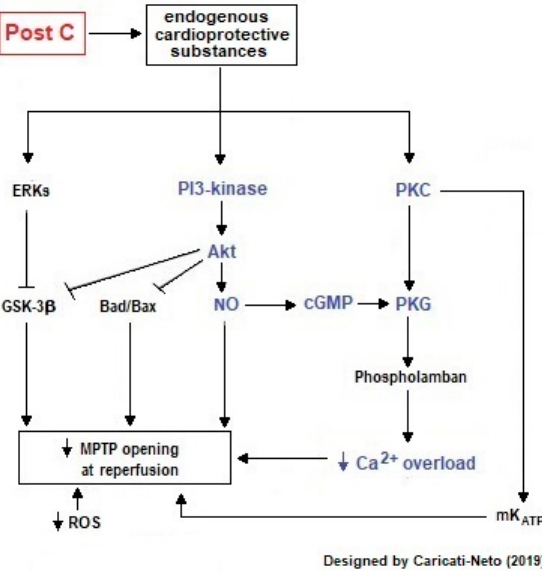
Figure 4. Intracellular signaling involved in cardioprotective response stimulated by ischemic postconditioning (PostC) in cardiac cells. This figure illustrates that PostC activates cellular survival pathways mediated by PI3K / Akt and increases cytosolic levels of NO in cardiac cells. This increase in NO biosynthesis activates intracellular signaling mediated by GC / cGMP / PKG pathway that produces increments in the activity of mK ATP channels, preserving the mitochondrial bioenergetics, and preventing the prolonged opening of the MPTP. The arrows represent activation signal and “T” bars represent inhibition